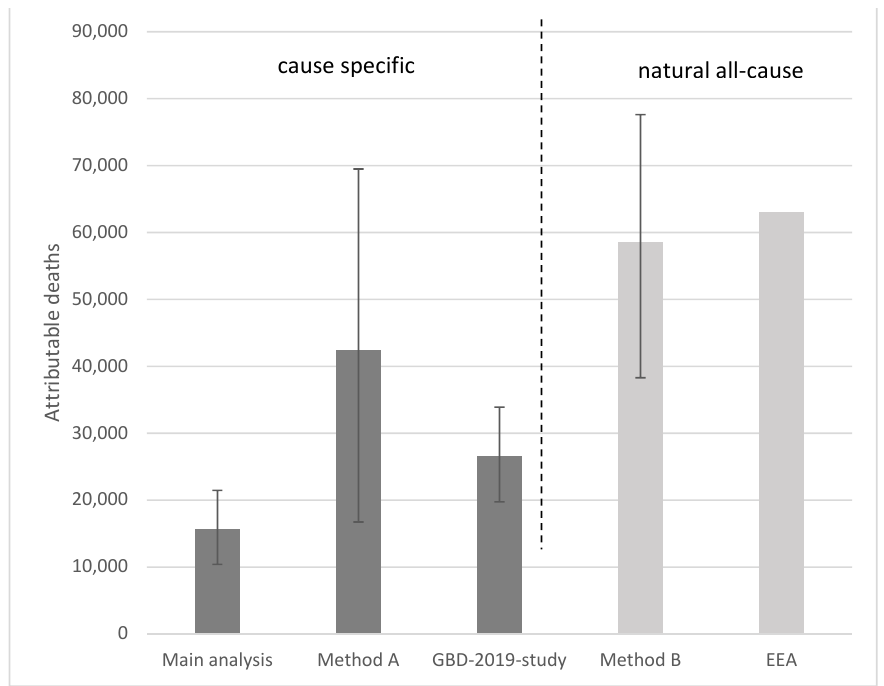
Figure 6. Attributable deaths that are due to PM 2.5 exposure in Germany 2018.